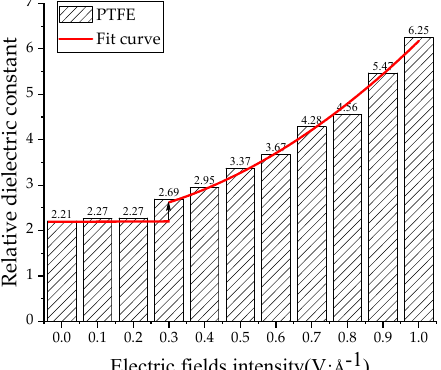
Figure 13. Variation of relative dielectric constant of PTFE model with electric fields.